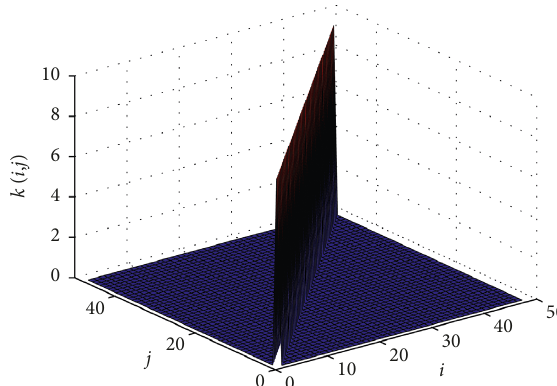
Figure 12: Control gains k